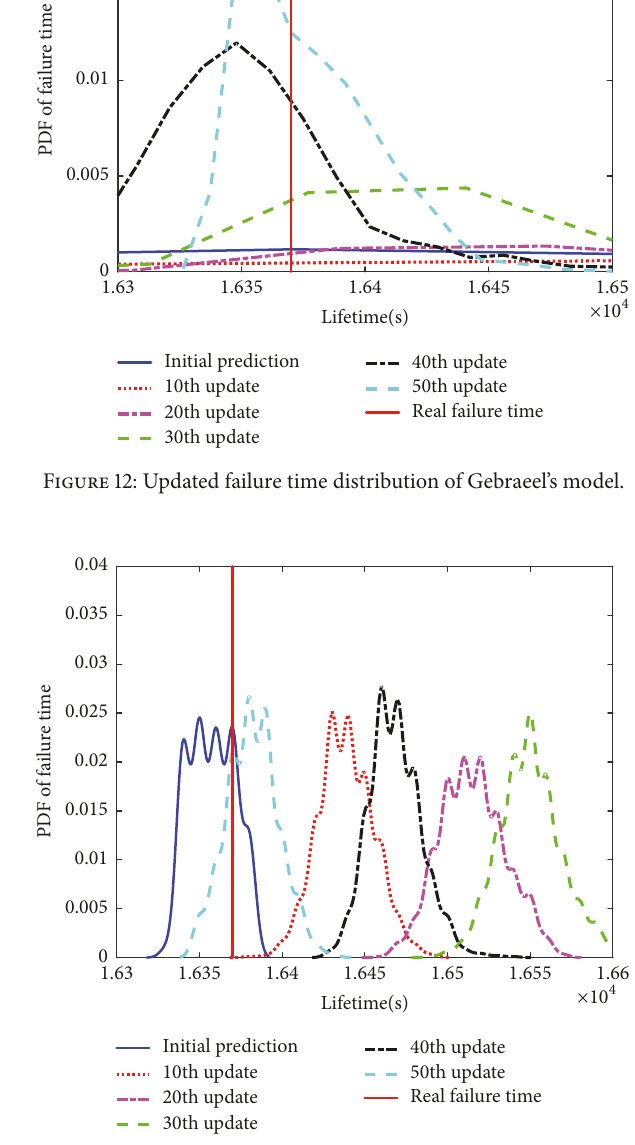
Figure 13: Updated failure time distribution of the linear